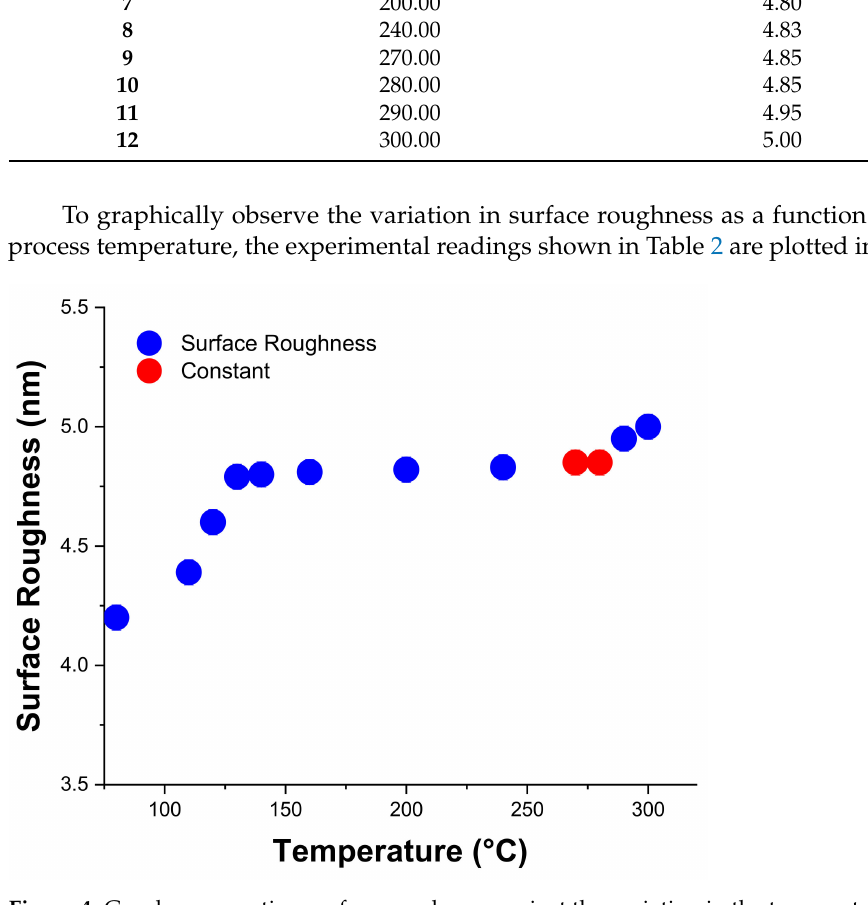
Figure 4. Graph representing surface roughness against the variation in the temperature using the PECVD